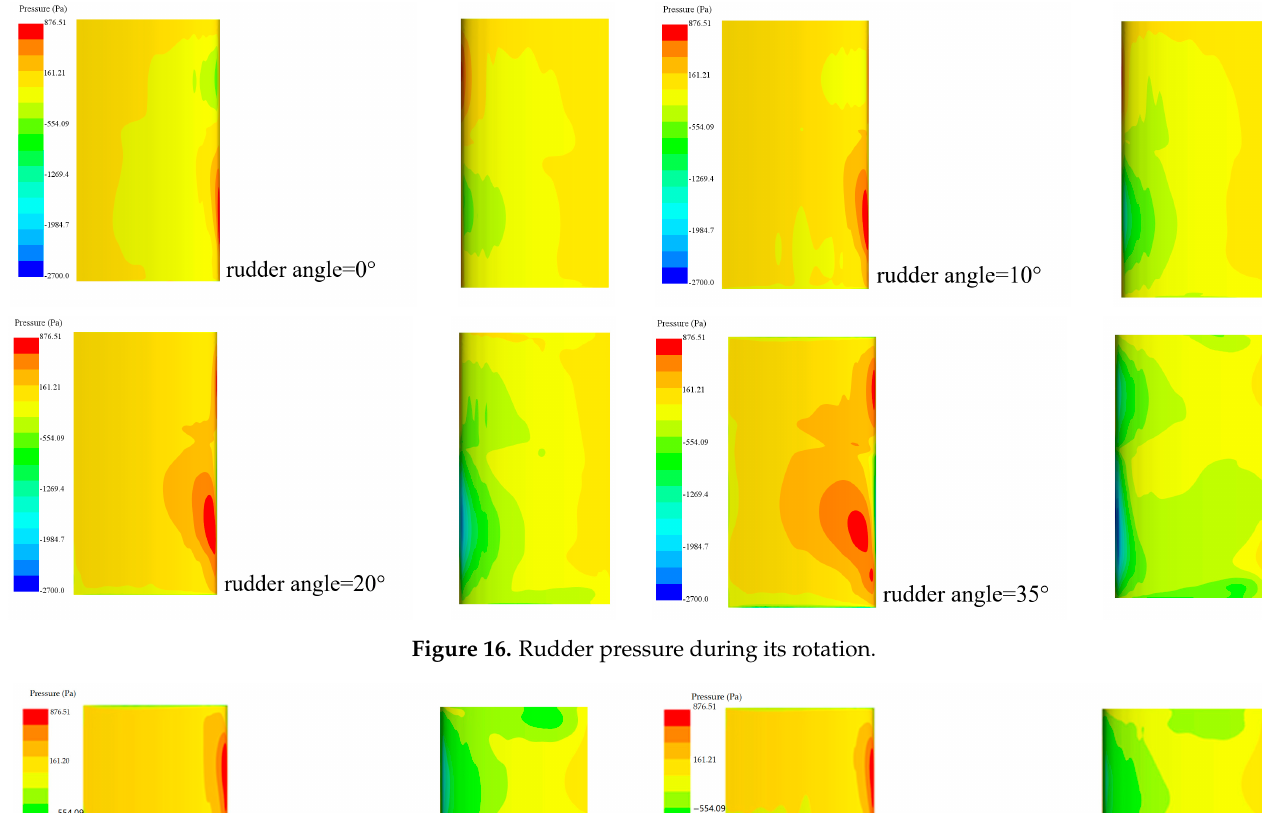
Figure 16. Rudder pressure during its rotation.